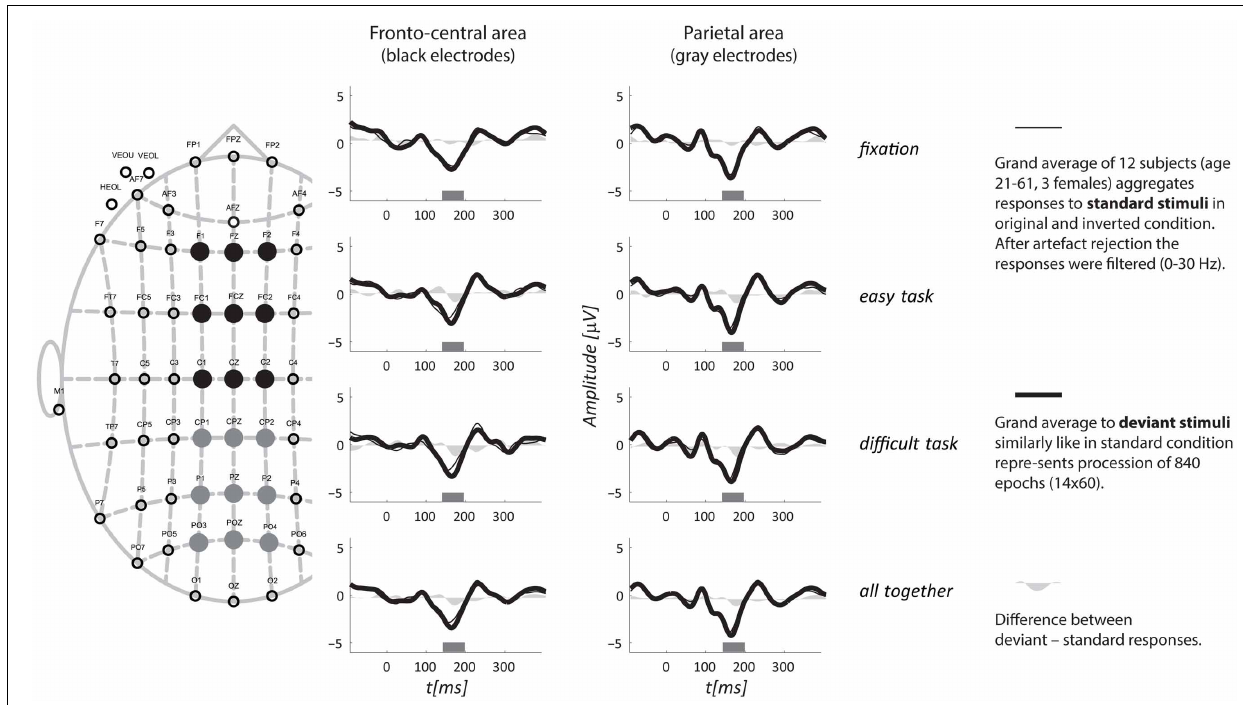
FIGURE 2 | Grand average ERPs for all three tasks aggregated from two regions. A schematic layout of the recording electrodes with indication of the fronto-central (full black circles) and the parietal (full gray circles) regions of interest is in the left portion of the figure. The top